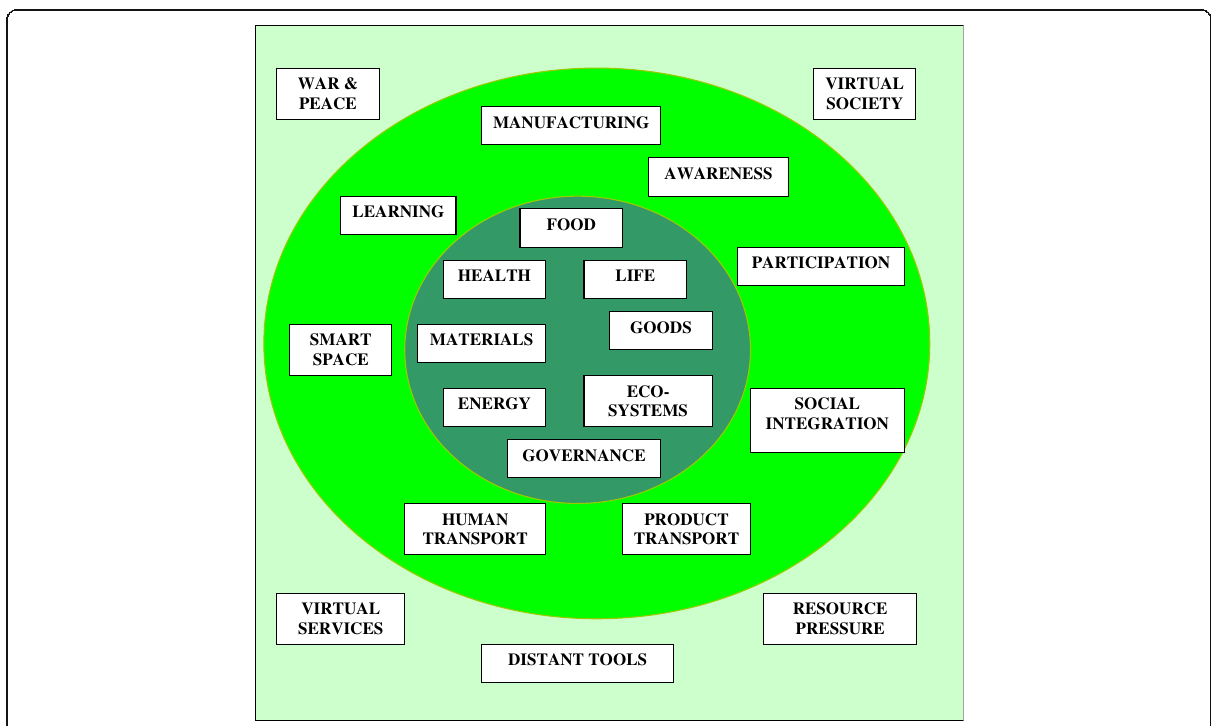
Fig. 1 A dynamic map of the demand forces for socio-technical change affecting the emergence of bioeconomy, driven by relevant global value chains and networks. The inner, dark green circle contains the Hard Core of Bioeconomic Demand GVNs, as defined in the text; the intermediate, bright green circle contains the Peripheral Bioeconomic Demand GVNs (see text); and the outer, light green circle contains the Peripheral Bioeconomic Demand GVNs (see above). Source: [8]